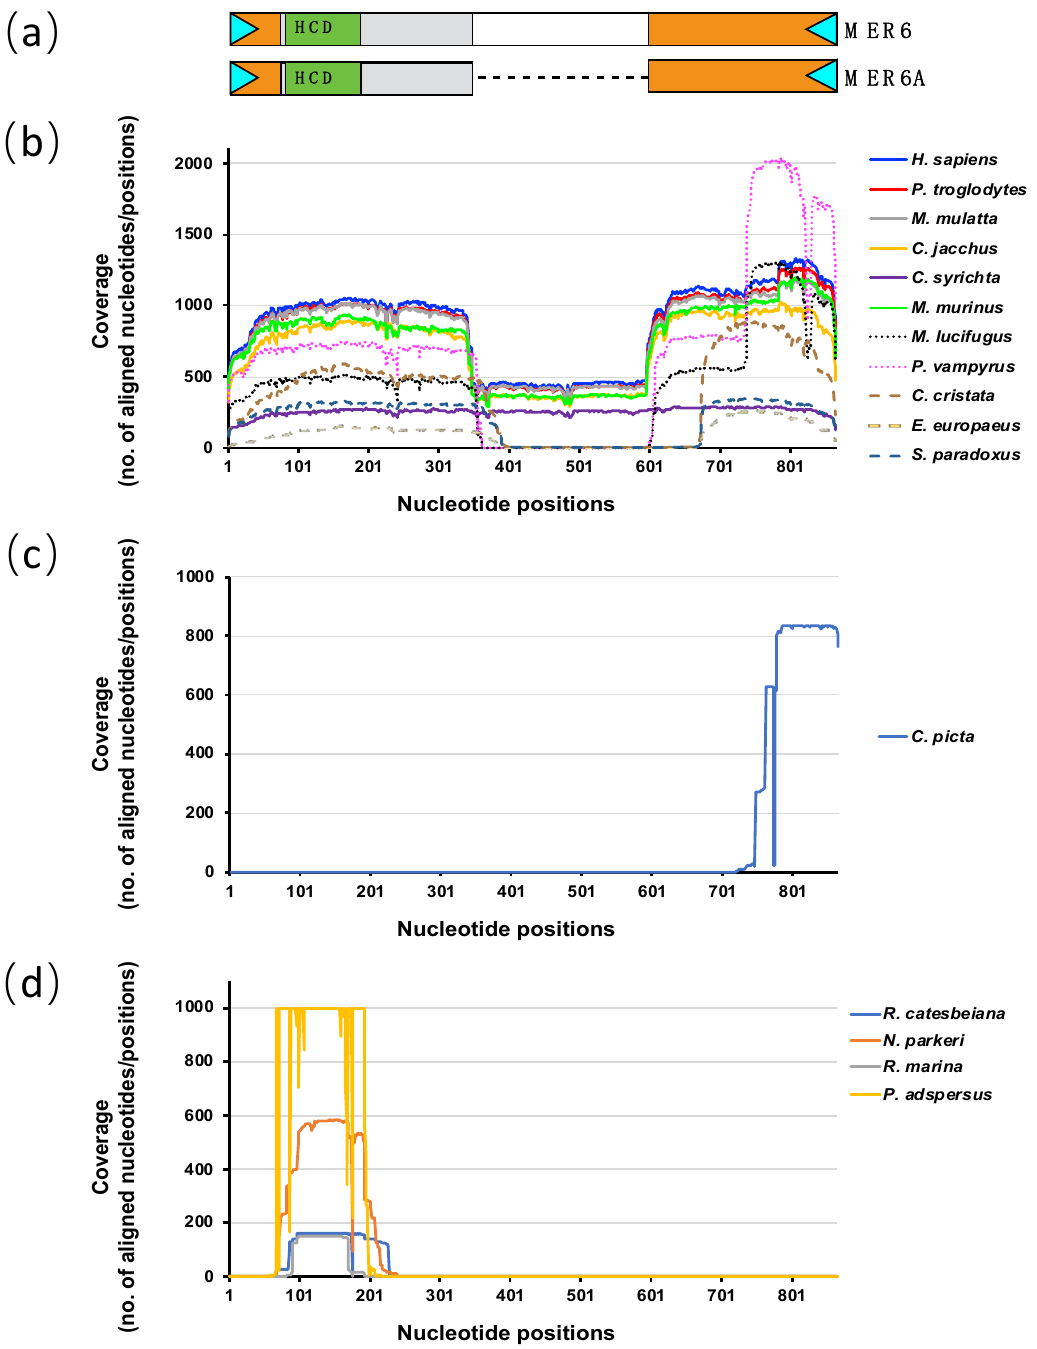
Figure 1. MER6 elements coverage from BLAST significant alignments. The schematic structure of MER6 elements is reported in ( a ) (cyan triangles: terminal inverted repeats; orange boxes: regions homologous to Mariner-2_CPB; grey boxes: regions homologous to Ac1 SINEs; green boxes: V highly conserved domains (HCD)). Sequence coverage from BLAST alignments with mammalian genomes ( b ), reptile genomes ( c ) and amphibian genomes ( d ).